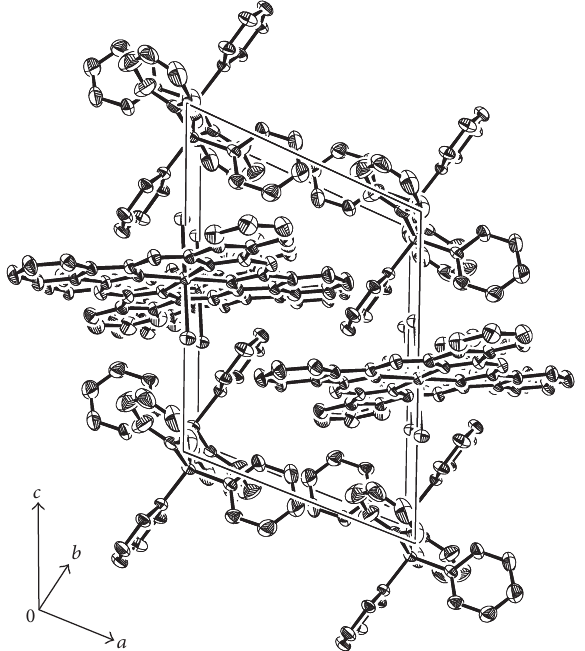
] (crystal system = 2